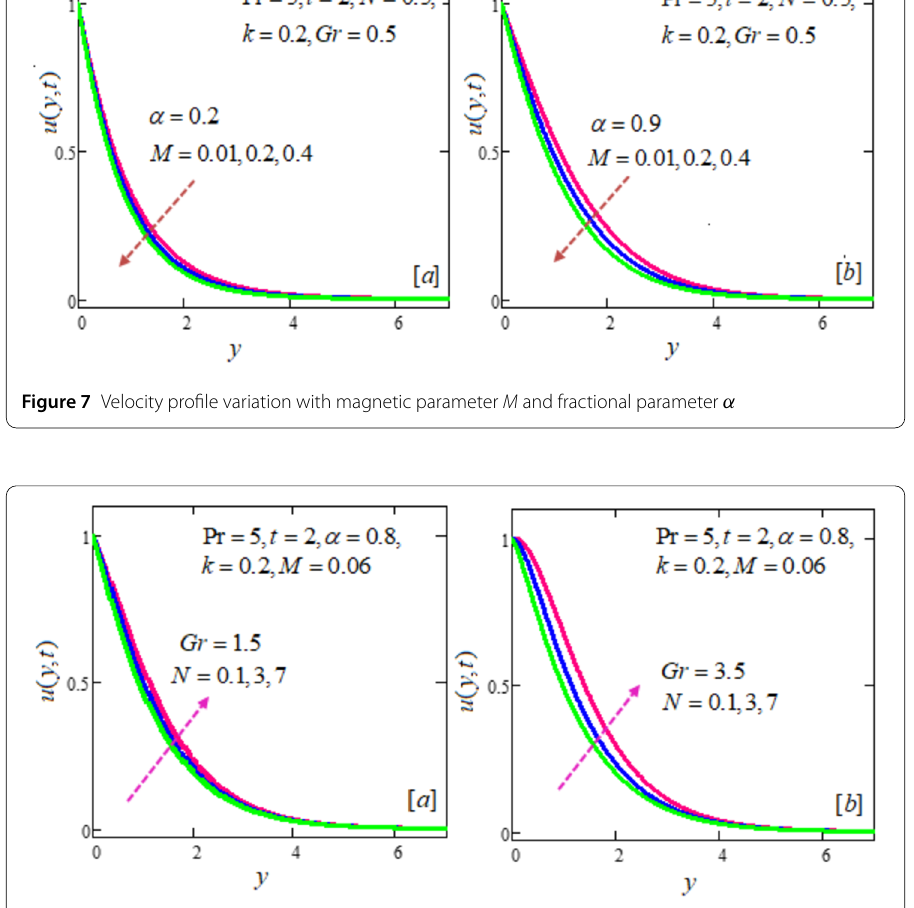
Fluid velocity tends to decrease gradually in Figs. 7(a) and 7(b), but the effect is more significant with higher velocity range in case of a greater value of α